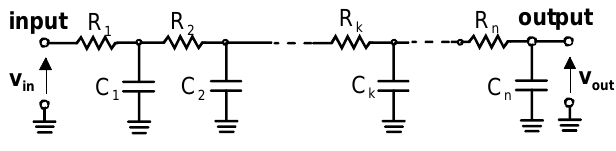
Figure 8: RC-network composed of n-cells in